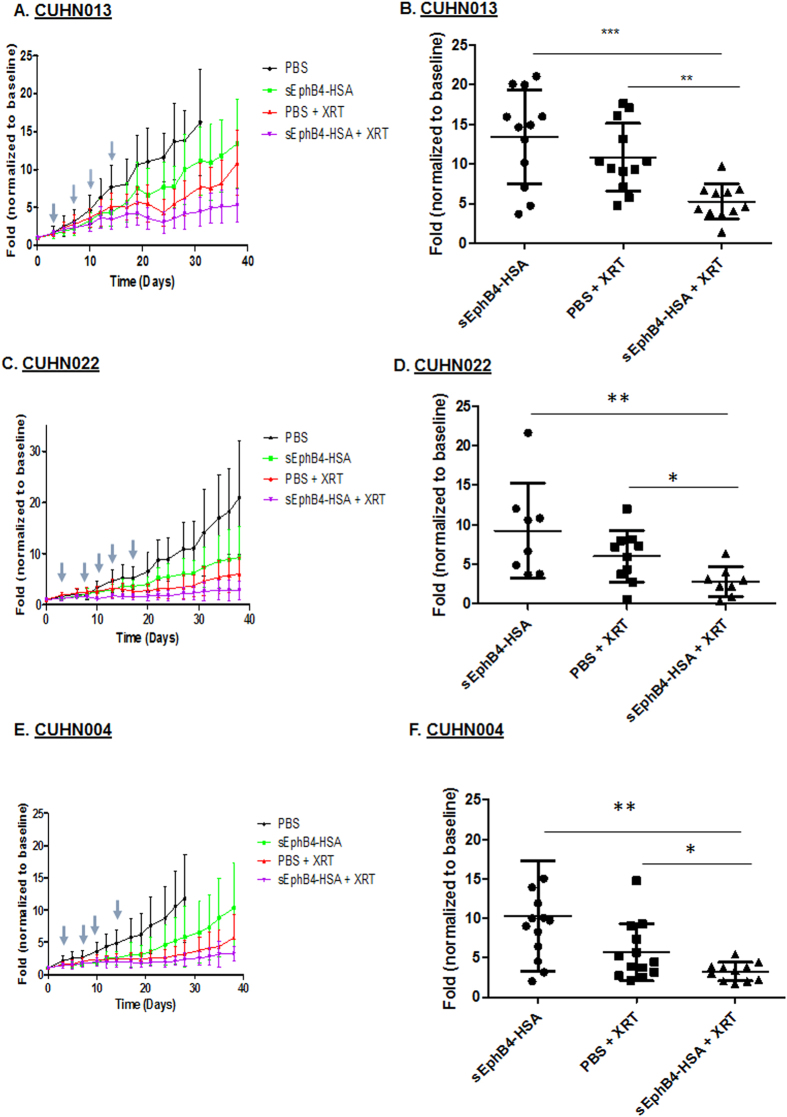
EphB4 targeting enhances radiosensitivity in HNSCC PDX models.Tumor growth analyses of CUHN013 PDX tumors (A,B), CUHN022 PDX tumors (C,D), and CUHN004 PDX tumors (E,F) show that sEphB4-HSA treatment combined with radiation significantly decreases tumor volume over time compared to single agent treatments. sEphB4-HSA was administered on days 0, 3, 5, 7, 10, 12, 14, 17, 19, 21, 24, 26, 28, 31, 33, 35, and 38. The symbol “↓” represent days when tumors were exposed to ionizing radiation (5 Gy/fraction for CUHN013 and CUHN004; 2 Gy/fraction for CUHN022). The mice in the PBS group were sacrificed on day 31 (CUHN013), or day 28 (CUHN004) because their tumors became too large. Data shown represent mean ± standard deviation. *p < 0.05,**p < 0.005, **p < 0.0005.